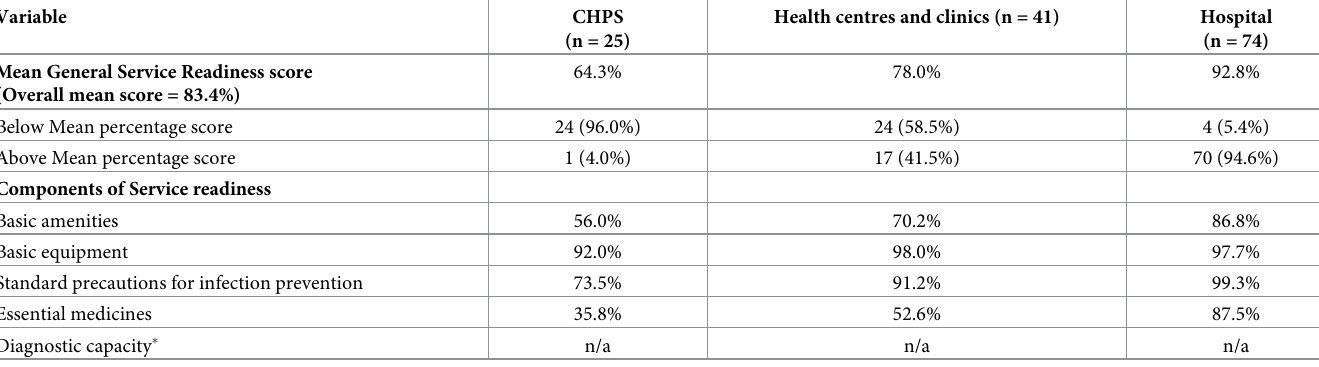
Table 3. Mean percentage score under each component of service readiness by facility